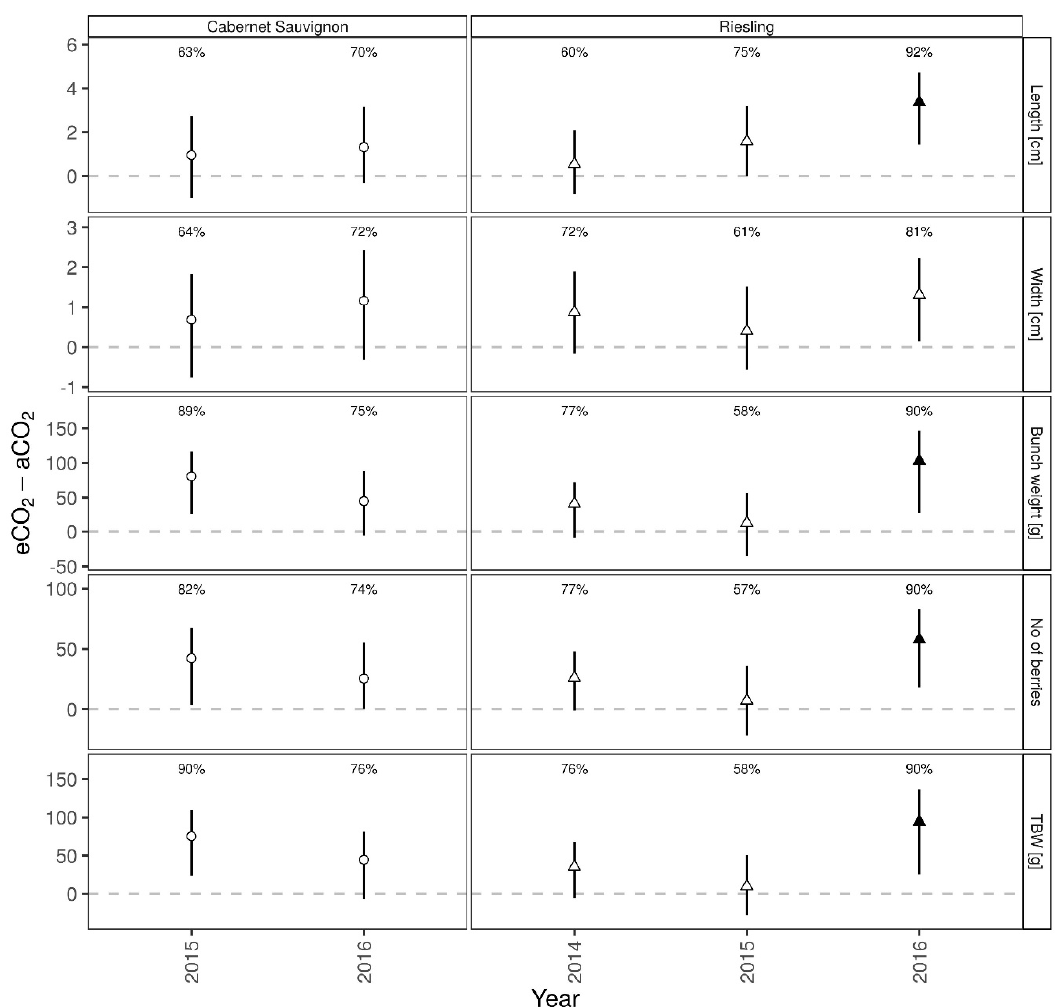
Figure 10. Posterior predicted difference (median and 50% HDI) between eCO 2 and aCO 2 for each measurement year from Bayesian generalized linear mixed effects models on bunch parameters of Riesling and Cabernet Sauvignon. Percentages represent the probability of eCO 2 -aCO 2 > 0. Filled symbols indicate “significant differences”, if the probability is >90% (positive difference) or <10% (negative difference).